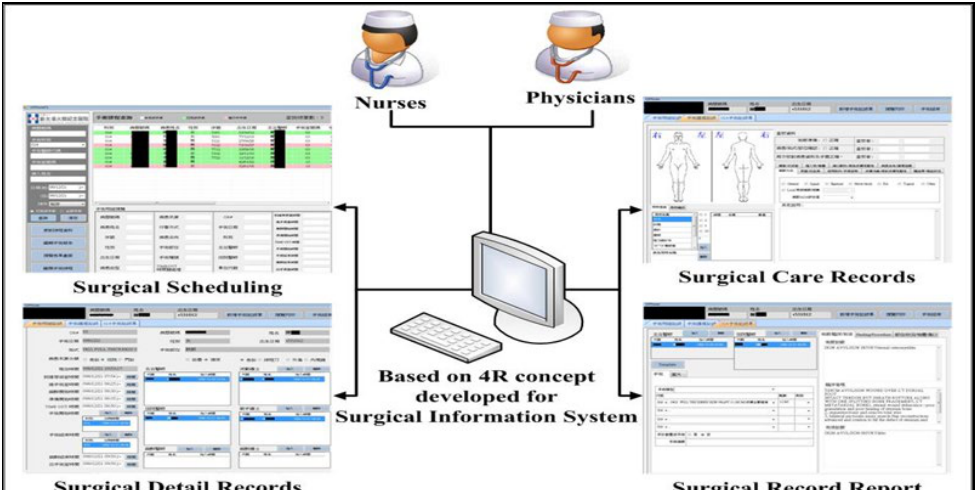
Figure 3. The recording